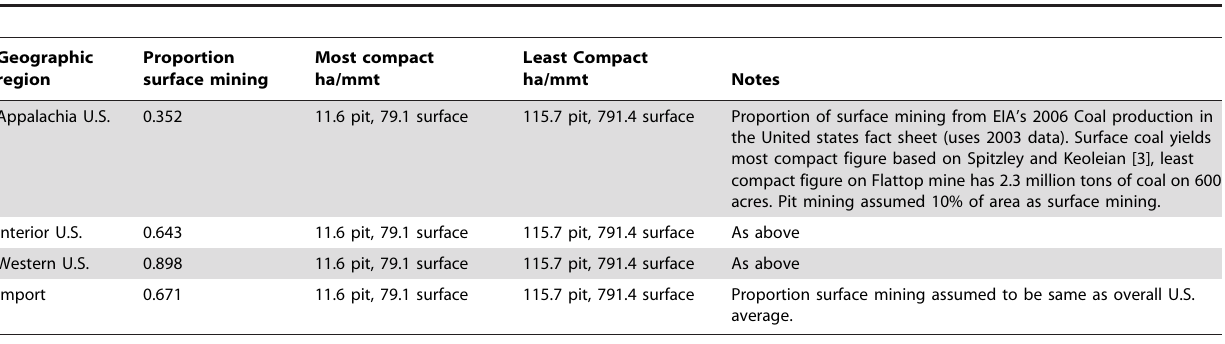
Table 2. Land-use intensity of production for coal mining.